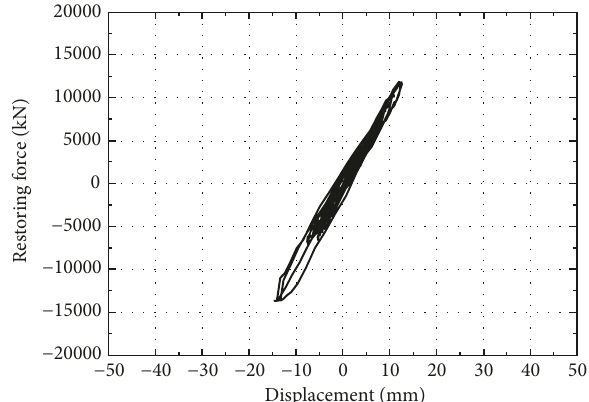
Figure 27: Hysteresis curve of intensity 7 fortification of syn- thesized (longitudinal input).